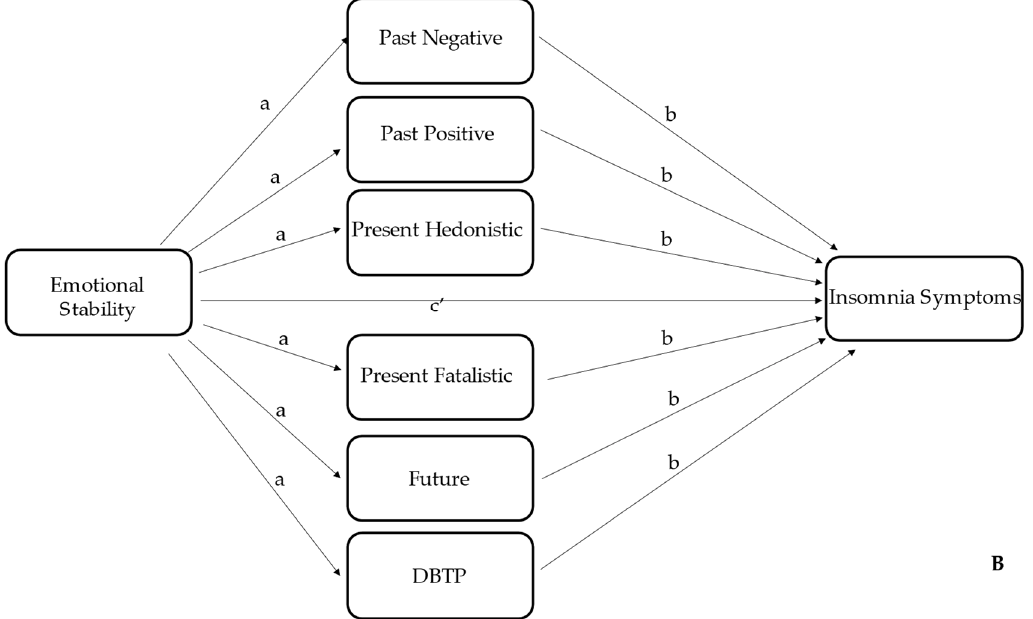
Figure 1. The mediation model tested. The a and b parameters indicate an indirect effect, while the c parameter indicates a direct effect. ( A ) the model tested the relationship between consciousness and insomnia symptoms through the mediation effect of each TPs and DBTP. ( B ) the model tested the relationship between emotional stability and insomnia symptoms through the mediation effect of each TPs and DBTP. Note that in both models the mediation analysis considered all TPs mediators at the same time.